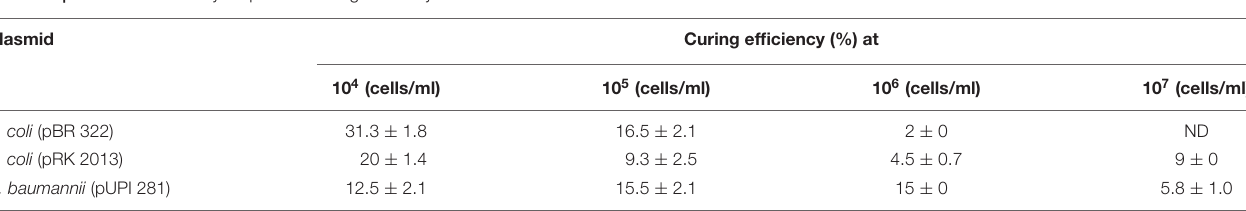
TABLE 5 | Effect of cell density on plasmid curing efficiency of lawsone. Plasmid